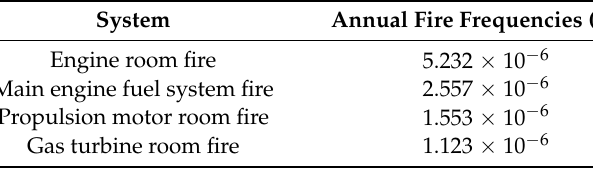
Table 12. The annual fire frequencies and safety risk indexes of the